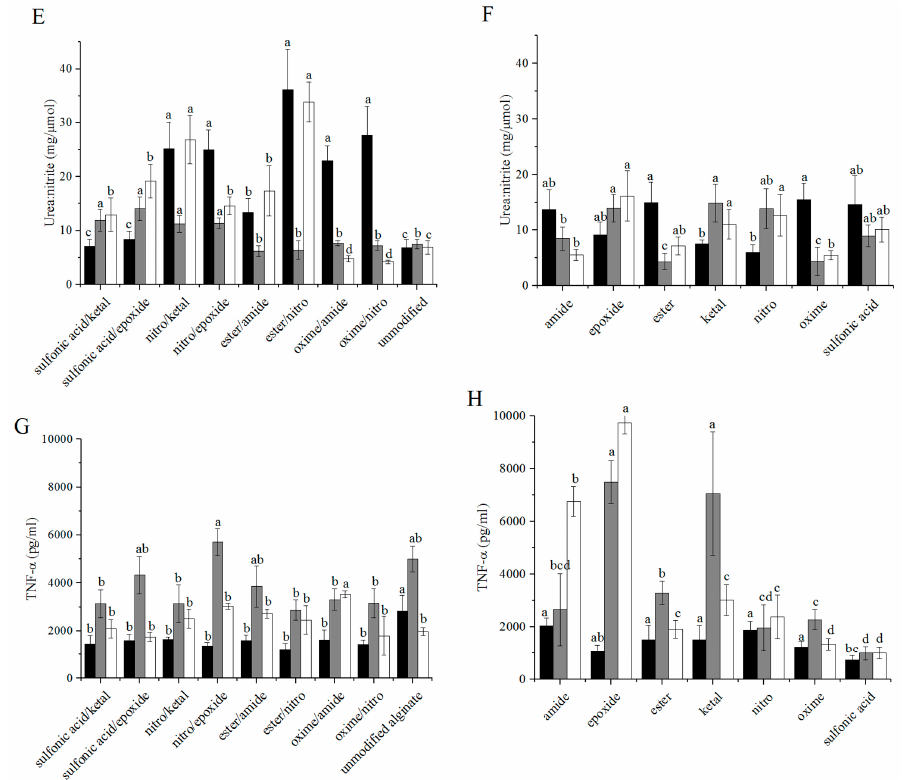
Figure 4. Molecules produced by polarized RAW 264.7 macrophages encapsulated under modified alginates. Alginates were layered over activated macrophages and: ( A , B ) nitrite; ( C , D ) urea; ( E , F ) urea:nitrite; and ( G , H ) TNF- α were measured for dual ( A , C , E , G ) and single ( B , D , F , H ) modifications. Arginase activity was measured by removing the alginate layer and lysing the cells. n = 4. Data represent the mean value ± standard deviation. Bars with the same letter (a–d) are not statistically different ( p < 0.05) from data points of the same activation.